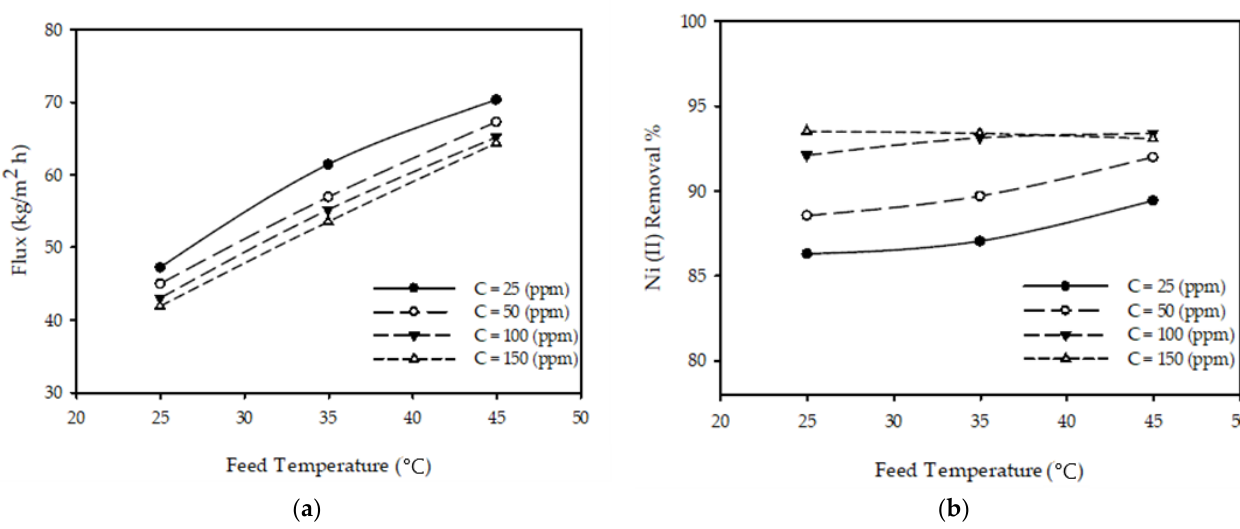
Figure 2. Temperature impact on ( a ) permeate flux and ( b ) Ni (II) removal % for various inlet concentrations with a pressure of 10 bar and a constant feed flow rate of 3.2 L/min.